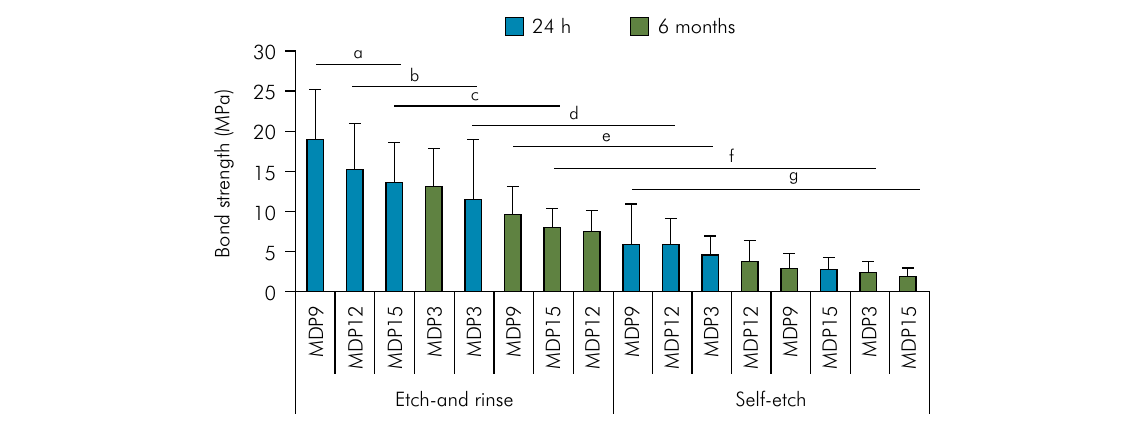
Figure 1. Bar plot showing the μ SBS means and standard deviations for all the groups. Groups sharing the same horizontal line and letter are statistically similar (p > 0.05).